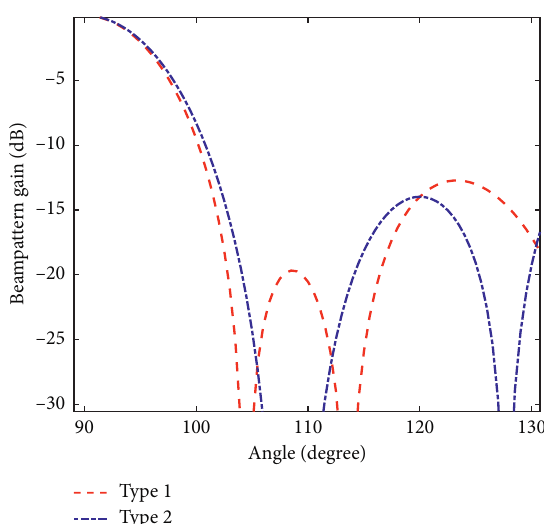
Figure 5: Beampattern of type 1 and type 2 arrays.